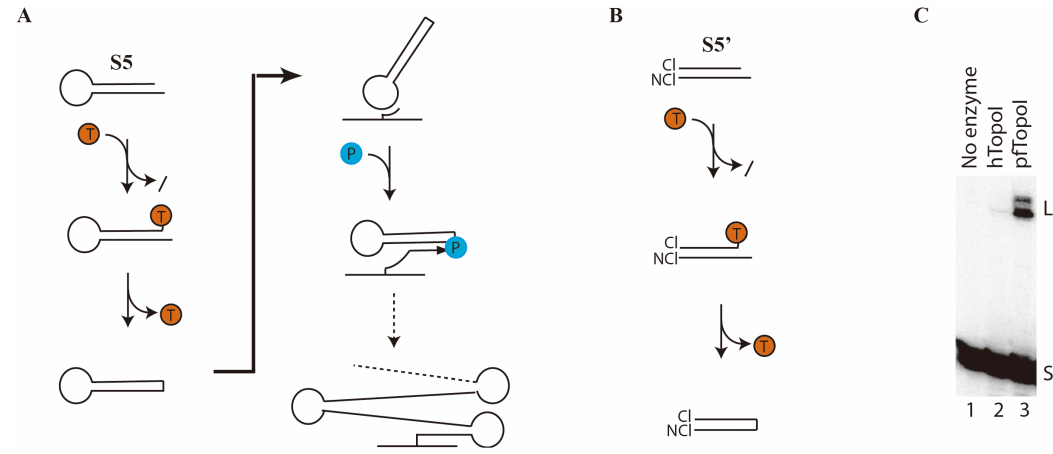
Figure 1. Specific detection of pfTopoI activity using S5' ( a ) REEAD [2]: S5 is specifically cleaved and ligated by pfTopoI (indicated by a T in red circle) to form a covalently closed DNA circle (left panel). These DNA circles can be detected by rolling circle amplification (right panel) where the circle is hybridized to an immobilized DNA oligonucleotide that is extended by a DNA polymerase (indicated by a P in a blue circle) using the DNA circle as template. The result is a long detectable DNA molecule. ( b ) A DNA substrate (S5') for pfTopoI consisting of one strand that is cleaved by pfTopoI (cleaved strand, Cl) hybridized to its complementary (non-cleaved) strand (NCl) is used. Incubation with pfTopoI (indicated by a T in red circle) leads to cleavage of the substrate and subsequent fusion of the two DNA strands (see text for details). ( c ) 5'-radiolabeled, assembled substrate was incubated with either pfTopoI (lane 3), hTopoI (lane 2) or no enzyme (lane 1). The reaction products were separated in an 8% denaturing polyacrylamide gel. The bands corresponding to the radiolabeled substrate are indicated with S and the bands corresponding to the ligation product are indicated with L.